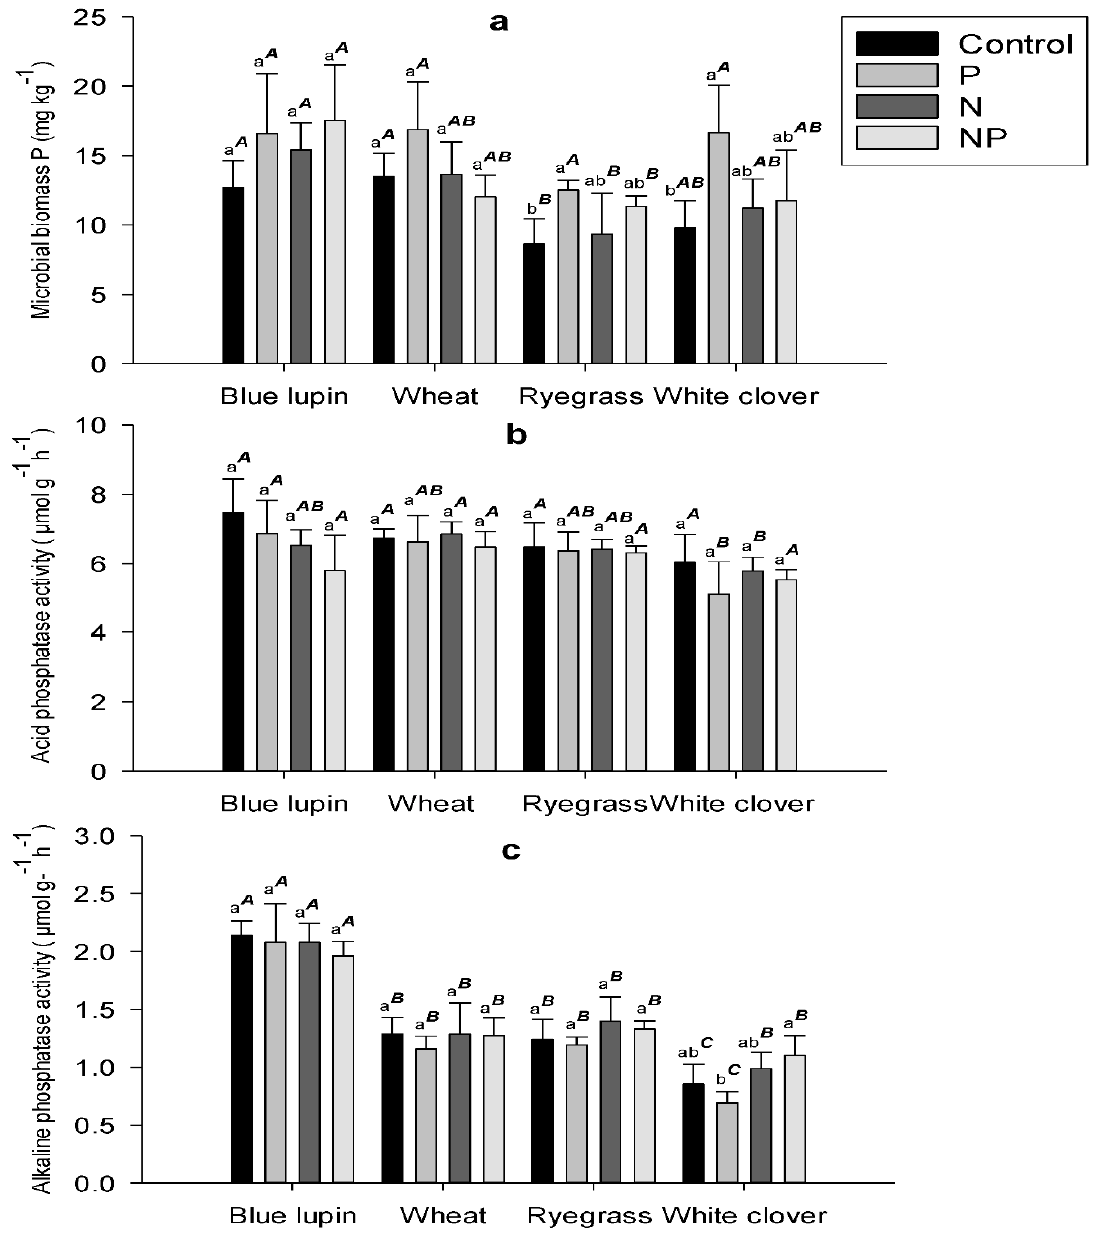
Figure 2. ( a ) Microbial biomass P, ( b ) acid phosphatase activity, and ( c ) alkaline phosphatase activity values in the rhizospheres of blue lupin, wheat, ryegrass, and white clover for the control (0N, 0P), P (0N, 33P), N (200N, 0P), and NP (200N, 33P) treatments. Different letters represent a significant difference ( p < 0.05) among nutrient treatments for the same plant. Different superscript letters represent a significant difference ( p < 0.05) among plant species for the same nutrient treatment.